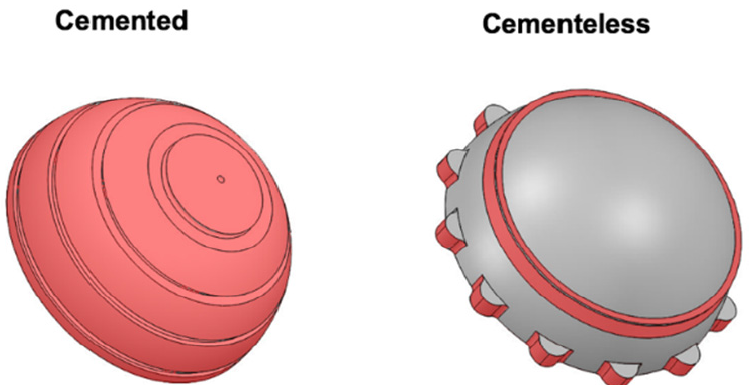
Figure 2. Cemented and uncemented polyethylene liner geometries. The red areas show the restriction points on the external surface for FE analysis.